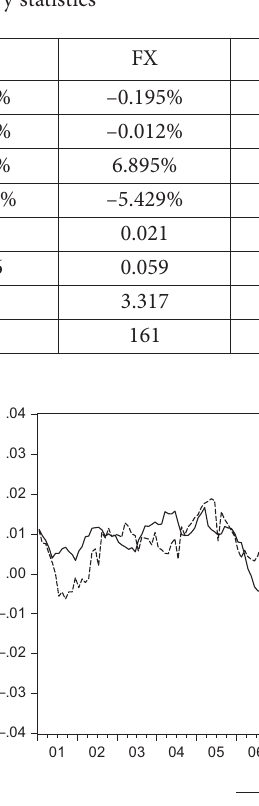
Figure 3. Time series plot for commercial and residential real